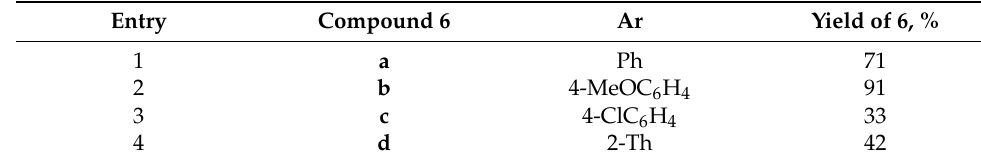
Table 4. The scope of products 6